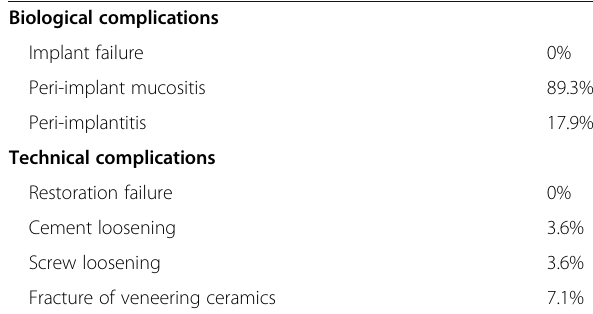
Table 2 Mean marginal peri-implant bone level (mm) and mean marginal peri-implant bone level change (mm)